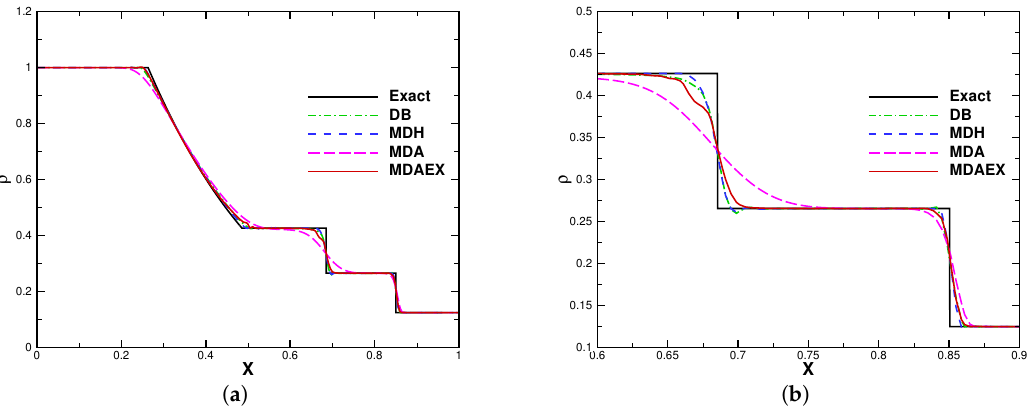
Figure 4. Density solution for the Sod problem with 100 elements at t = 0.2, P 2. ( a ) Overview; ( b ) zoomed in results.